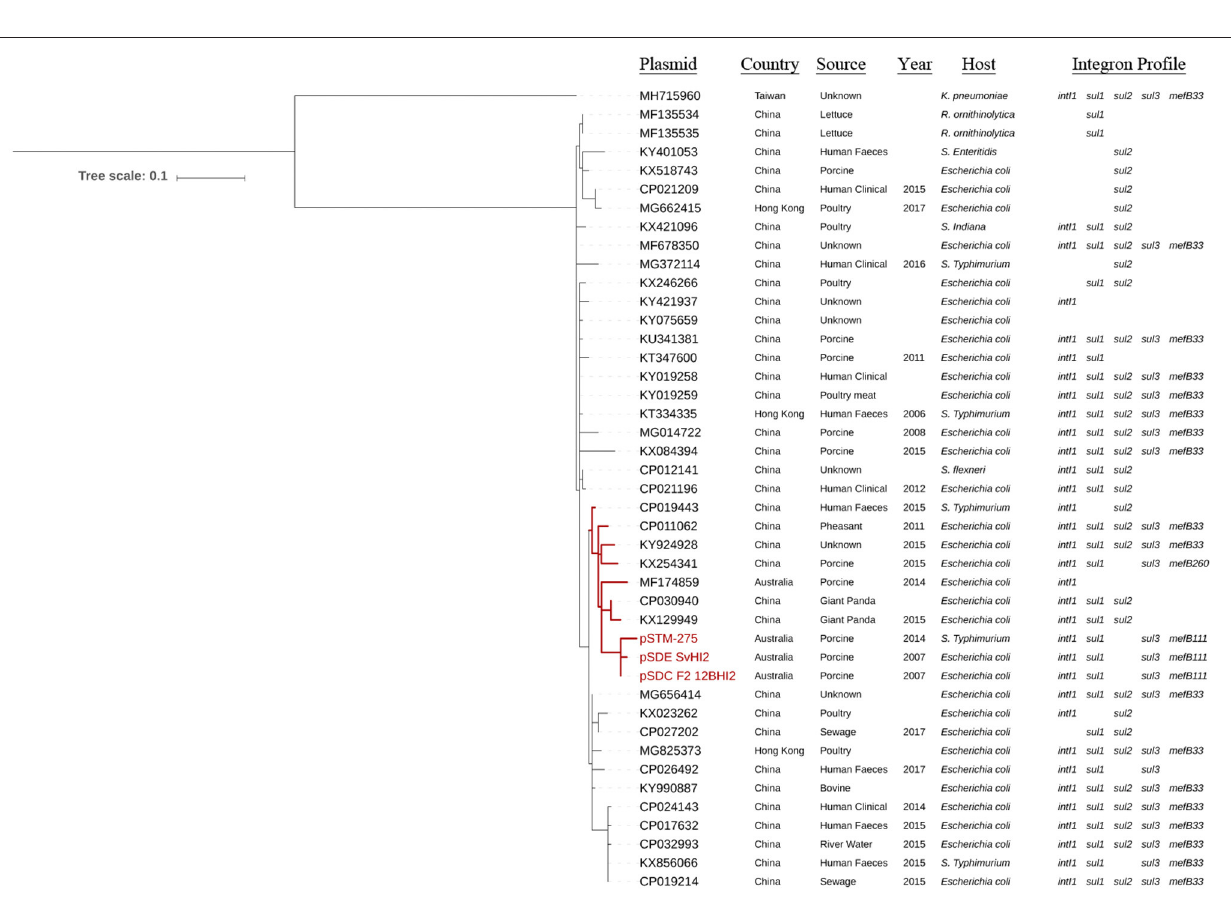
FIGURE 2 | Core phylogeny of IncHI2:ST3 plasmid sequences. Mid-point rooted phylogram constructed using Parsnp, using a conserved core SNP alignment of IncHI2 ST3 sequences, with pSDC-F2_12BHI2 as reference. Sequence metadata and the presence of integron marker genes is also included. Scale shows number of SNPs per